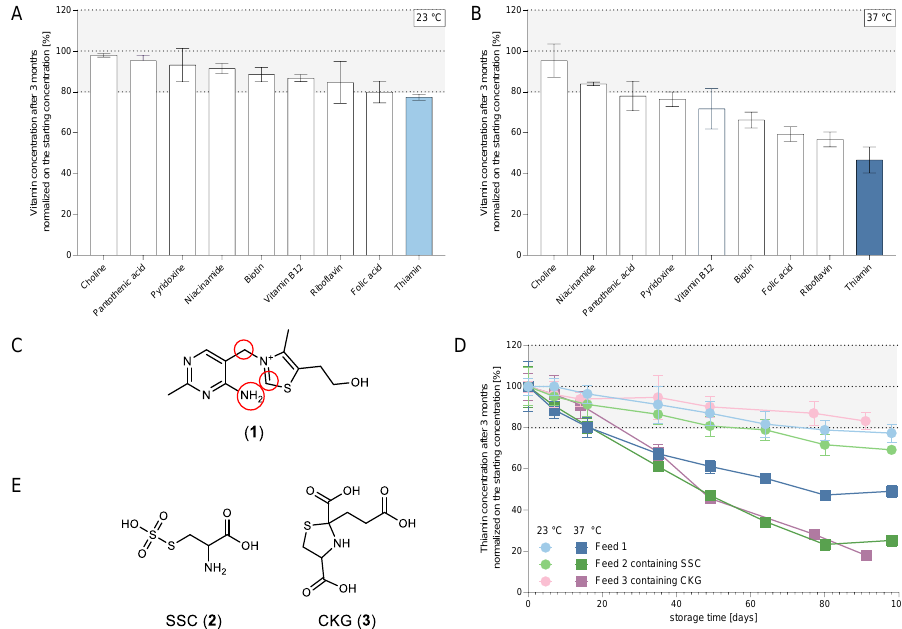
Figure 1. Vitamin concentration in feed 1 after 98 days storage at ( A ) 23 ◦ C or ( B ) 37 ◦ C normalized on the starting values. ( C ) Structure of thiamin ( 1 ) with chemical groups susceptible to oxidation and reduction highlighted in red. ( D ) Thiamin concentration in formulations containing different Cys sources (feed 2 containing SSC ( 2 ) and feed 3 containing CKG ( 3 )) after maximum 98 days storage at 23 ◦ C and 37 ◦ C normalized on the starting values. ( E ) Structure of used Cys sources SSC ( 2 ) and CKG ( 3 ). The grey area represents the common technical variability of the method.